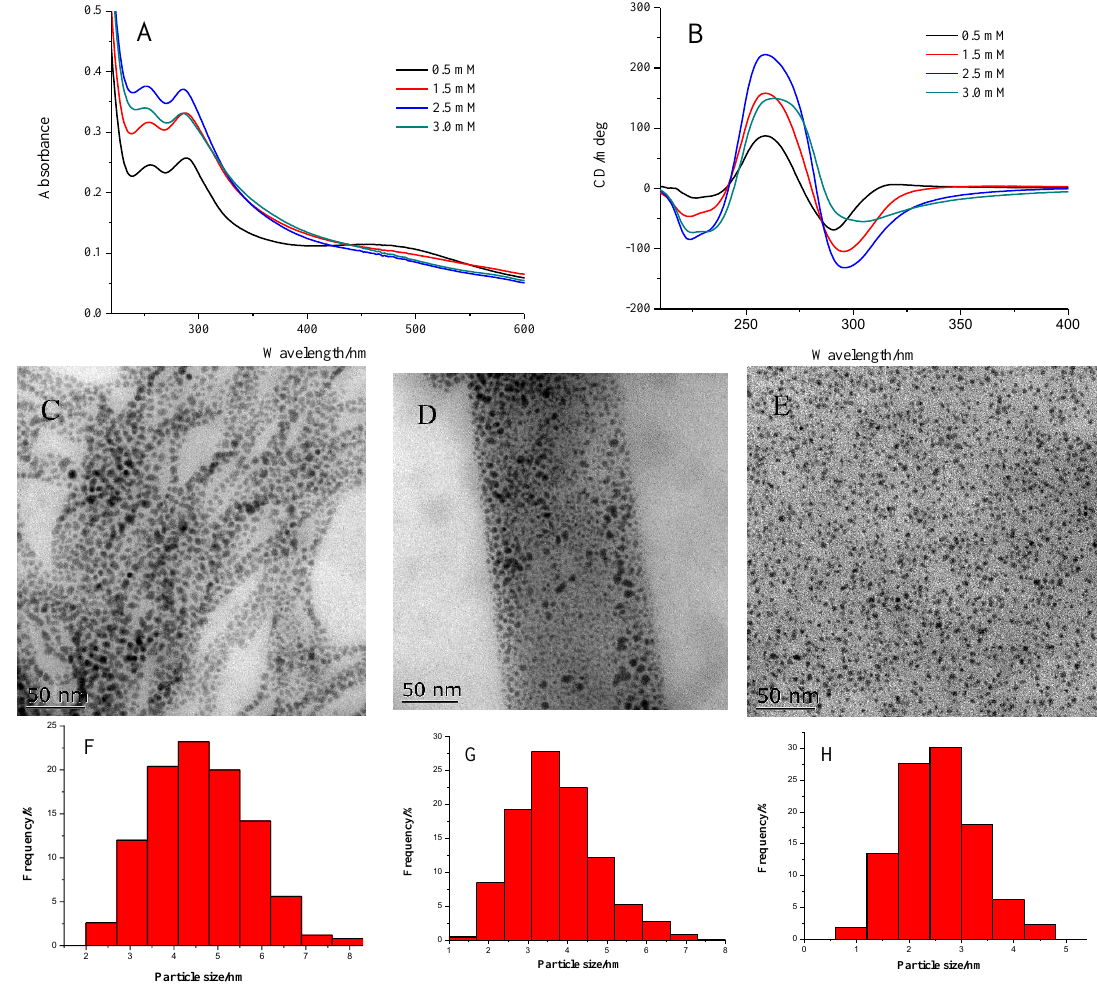
Figure 2. The evolutions of ( A ) UV-Vis absorption and ( B ) circular dichroism (CD) spectra of L-Cys capped Ag nanoparticles (NPs) with the varied concentrations of L-Cys. Transmission electron microscopy (TEM) images of L-Cys capped Ag NPs prepared at different concentrations of L-Cys: ( C ) 0.5 mmol · L − 1 ; ( D ) 1.5 mmol · L − 1 and ( E ) 2.5 mmol · L − 1 ; ( F – H ) demonstrates the size distribution of L-Cys capped Ag NPs corresponding to ( C – E ), respectively.